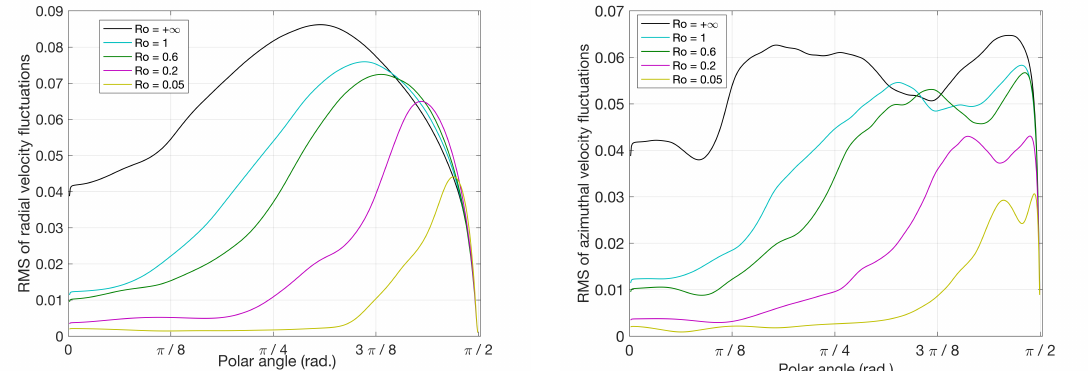
Figure 10. Method 1. Left: Radial velocity component fluctuations RMS for various values of the Rossby number Ro . Right: Azimuthal velocity component fluctuations RMS for various values of the Rossby number Ro